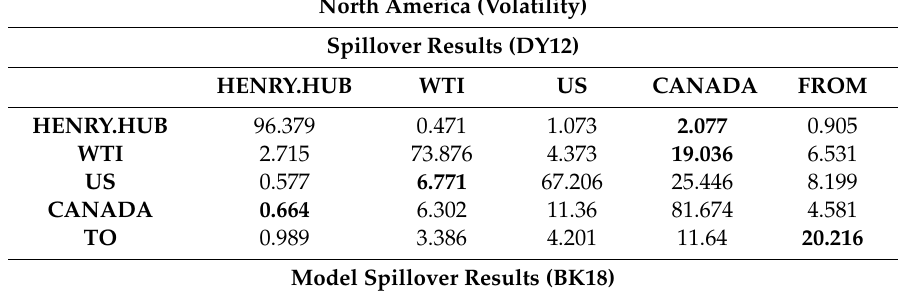
Table 6. Volatility spillover table of DY12 and BK18 (North America). North America (Volatility) Spillover Results